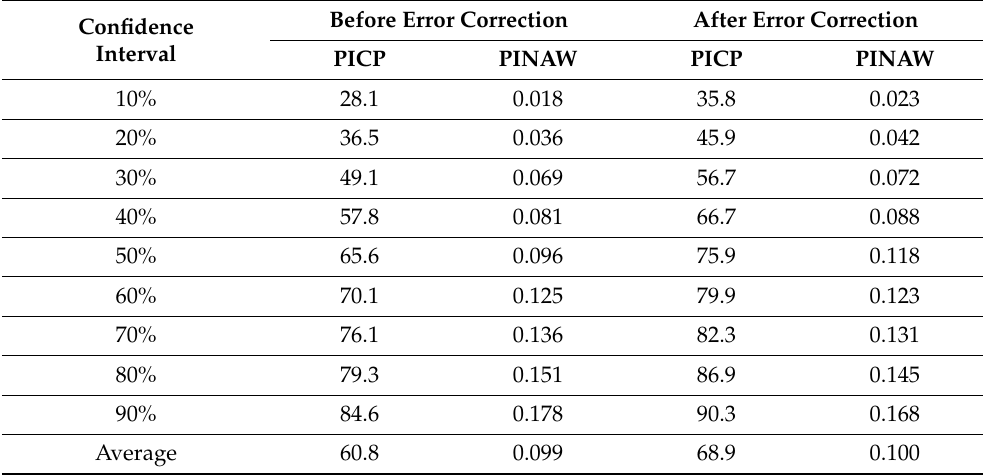
Table 5. Prediction accuracy before and after error correction in Set